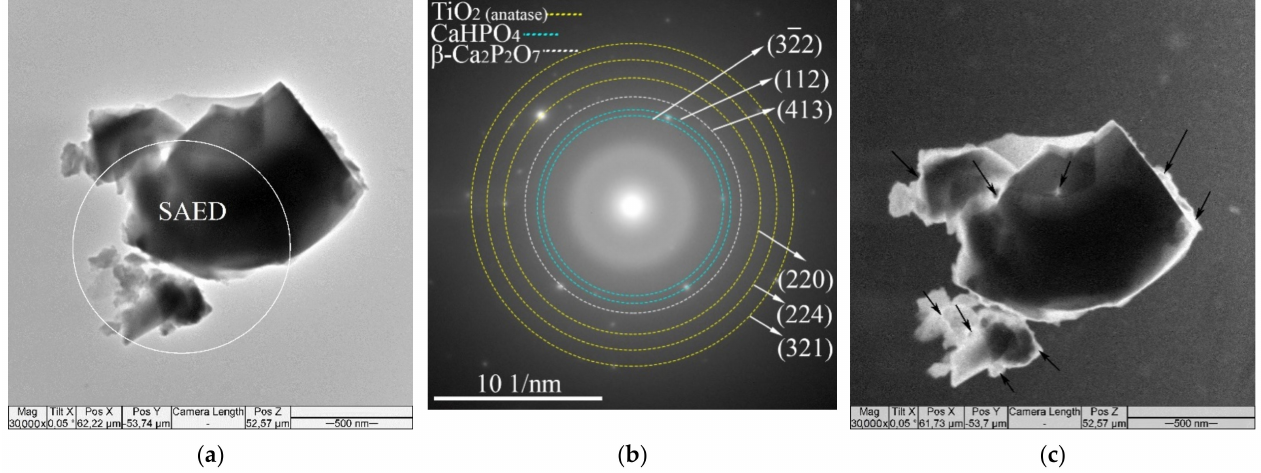
Figure 3. BF TEM ( a ) and DF TEM ( c ) images and SAED pattern ( b ) of the particles of the MAO CaPcoatings. The area where SAED was conducted is marked with a white circle ( a ). Nanocrystallites of the CaHPO 4 phase in the reflex (112) are marked with black arrows ( c ).